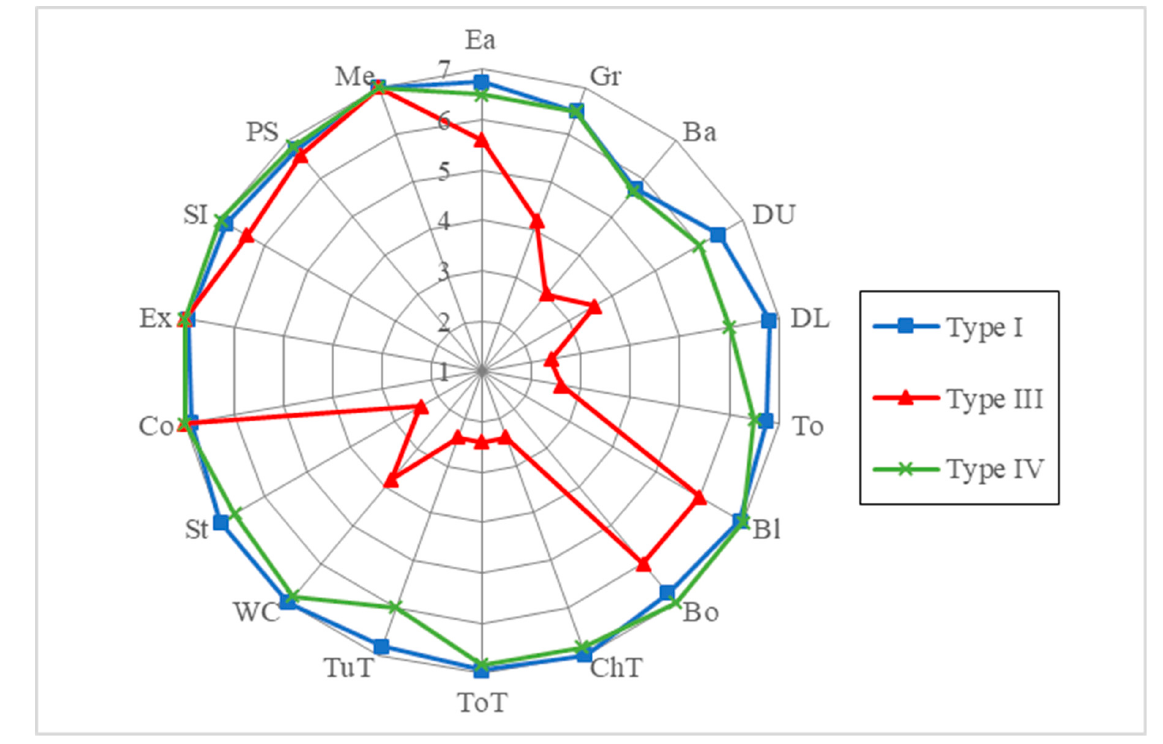
Figure 1. WeeFIM profiles of the study participants stratified by clinical type of OI.